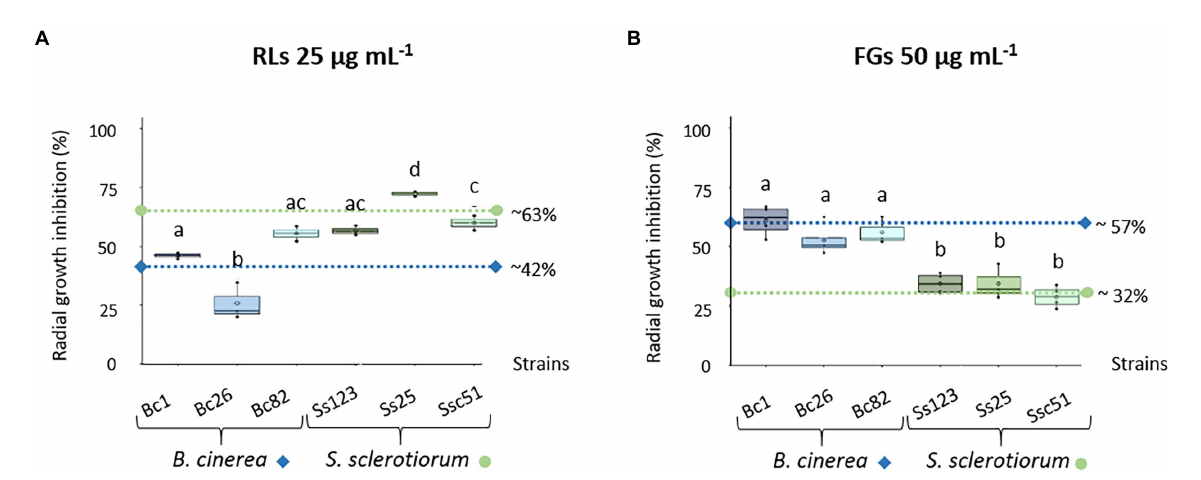
FIGURE 1 Sensitivity of different Botrytis cinerea (Bc1, Bc26, Bc82) and Sclerotinia sclerotiorum (Ss123, Ss25, Ssc51) strains to RLs and FGs. Radial growth inhibition of different B. cinerea and S. sclerotiorum strains in response to 25 μ g mL − 1 RLs (A) or 50 μ g mL − 1 FGs (B) . Data correspond to means of three biological repetitions, whiskers correspond to inter-quartile ranges and letters indicate significant differences ( p < 0.05) between the groups. Dotted lines correspond to the mean inhibition growth of each fungus species, diamonds and circles for B. cinerea and S. sclerotiorum ,